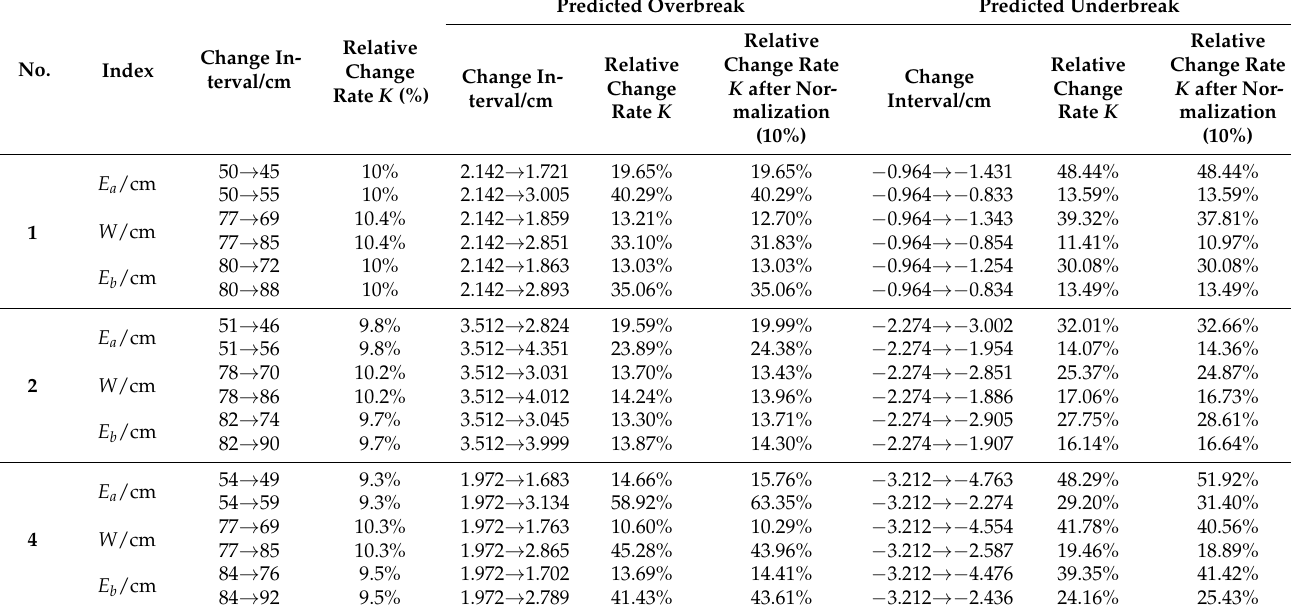
Table 10. Sensitivity calculation of indices for optimization of SWB.